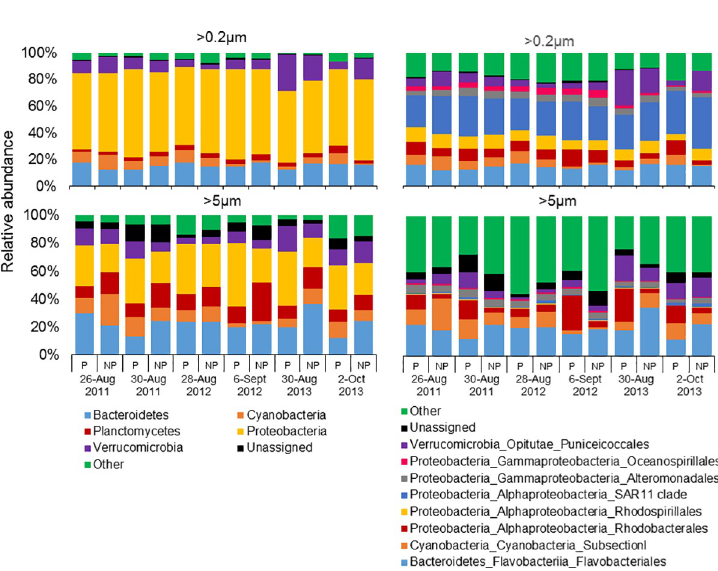
Fig 5. Phylum- (left panel) and Order- (right panel) level relative abundances of bacterial sequences from size fractionated ( > 0.2 and > 5 micron) samples collected within and immediately adjacent ( < 10m) to the Cochlodinium bloom patches, designated ‘patch’ (P) and ‘non-patch’ (NP) samples, respectively, for years 2011, 2012 and 2013.